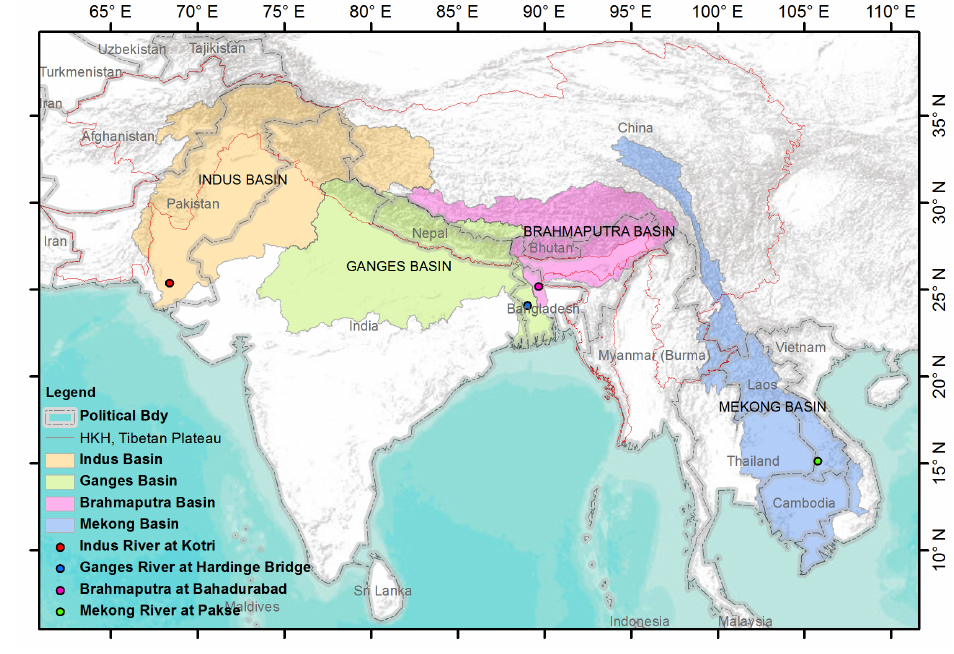
Figure 1. Major South and Southeast Asian river